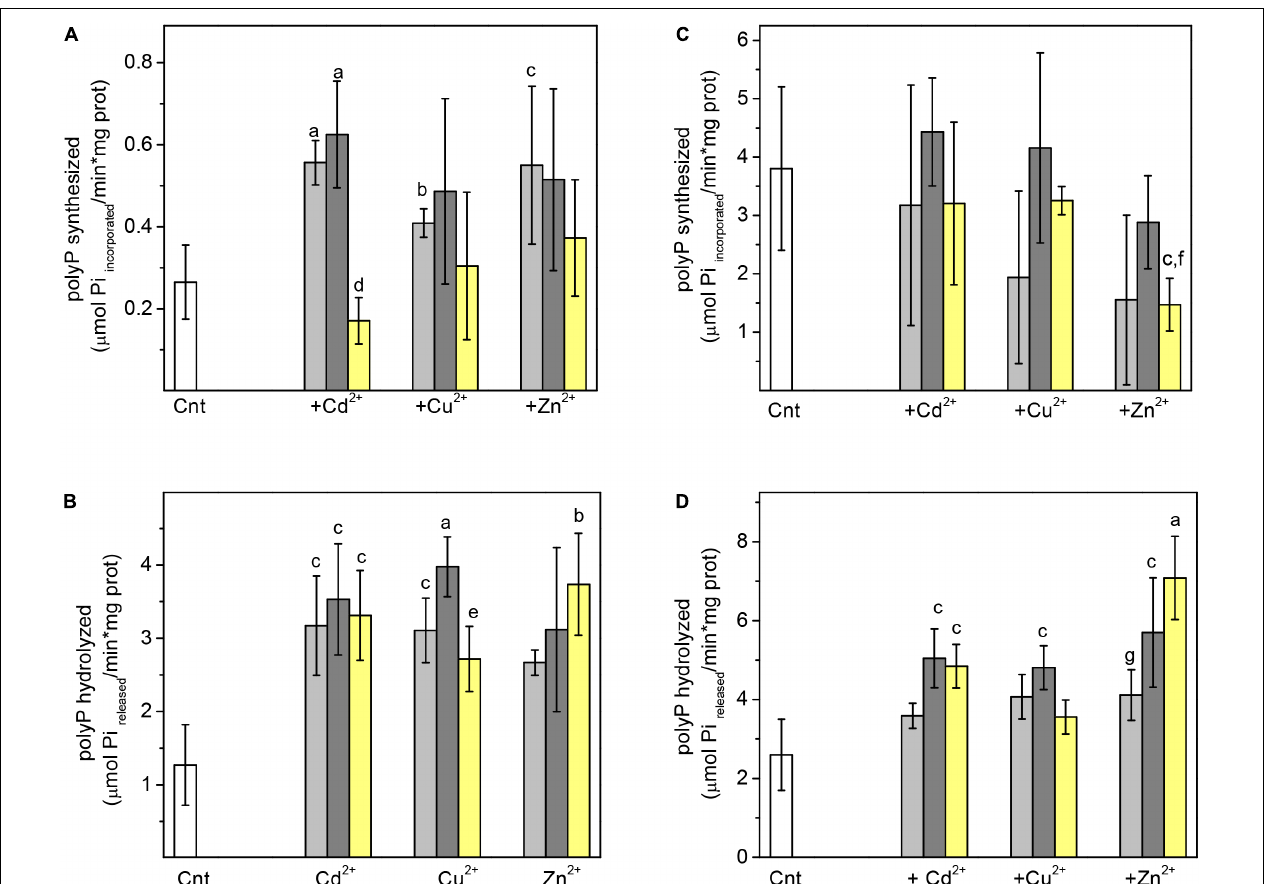
FIGURE 4 | Effect of heavy metal on the activity of recombinant Ma-PPK and Ma-PPX Activities of PPK and PPX in presence (A,B) or absence of 120 mM K + (C,D) , respectively, were determined in absence (white bar) or presence of 10 (light gray bar), 25 (dark gray bar) or 50 µ M (yellow bar) of the indicated heavy metal. The concentration of substrates was for PPK (A,C) 2.5 mM ATP and for PPX (B,D) 5 mg Trimethylsilyl polyP/mL, respectively. Student t -test for non-paired samples, a P < 0.01; b P < 0.025; c P < 0.05 vs. Cnt without heavy metal; d P < 0.01 vs . 10 and 25 µ M Cd 2 + ; e P < 0.05 vs . 25 µ M Cu 2 + ; f P < 0.05 vs . 25 µ M Zn 2 + ; g P < 0.025 vs . 50 µ M Zn 2 +